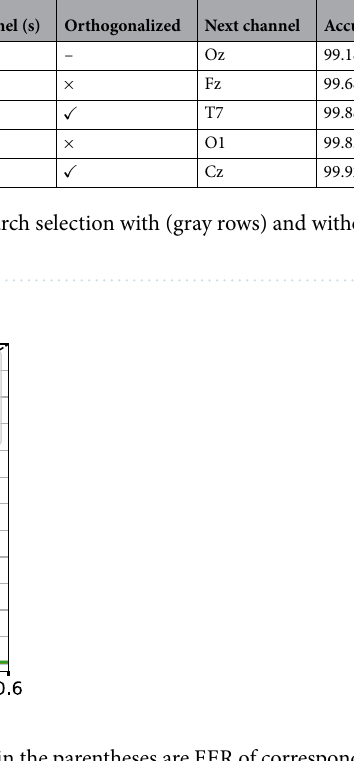
Figure 5. DET plot of different distance measures. The values in the parentheses are EER of corresponding distance in